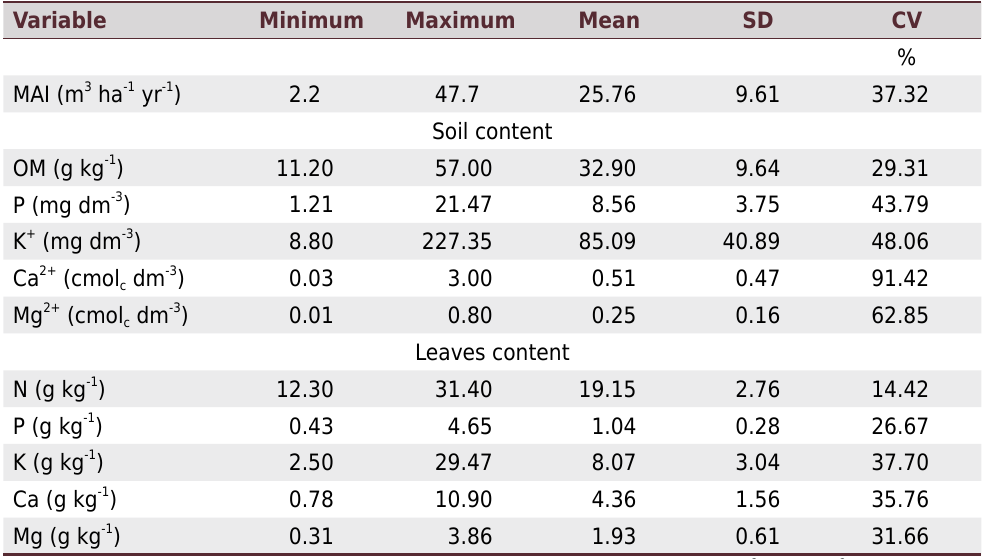
Table 1. Summary of the descriptive statistics for mean annual increment (MAI), contents of organic matter (OM) and macronutrients in the soil estimated for the start of planting and leaf contents of macronutrients in eucalyptus